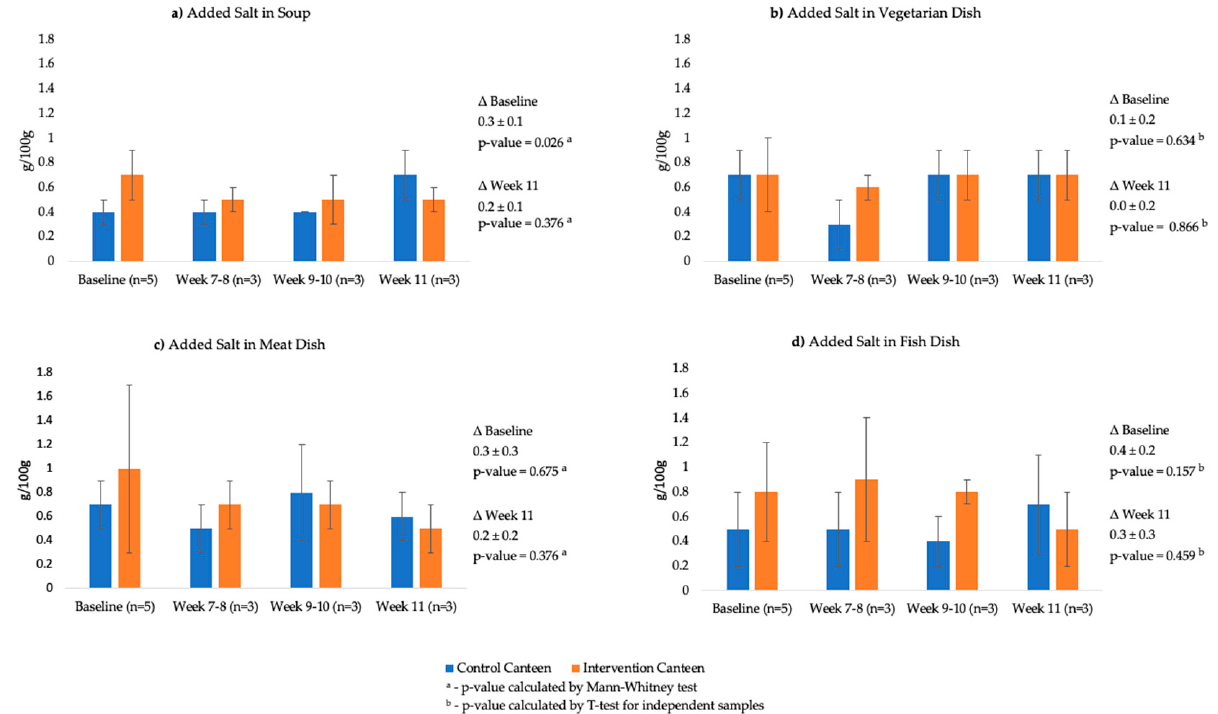
Figure 3. Values of added salt (g/100 g) over the course of the study in the control canteen and intervention canteen. Comparissons between canteens in the baseline period and in week 11. a — p - value calculated by Mann–Whitney test; b — p -value calculated by t -test for independent samples.